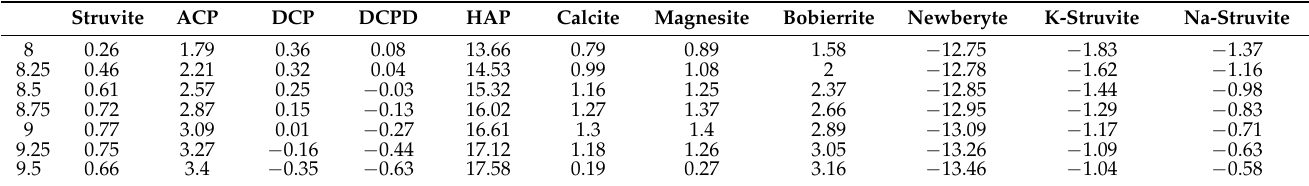
Table 3. PHREEQC calculated SI values for different P-containing solid phases.